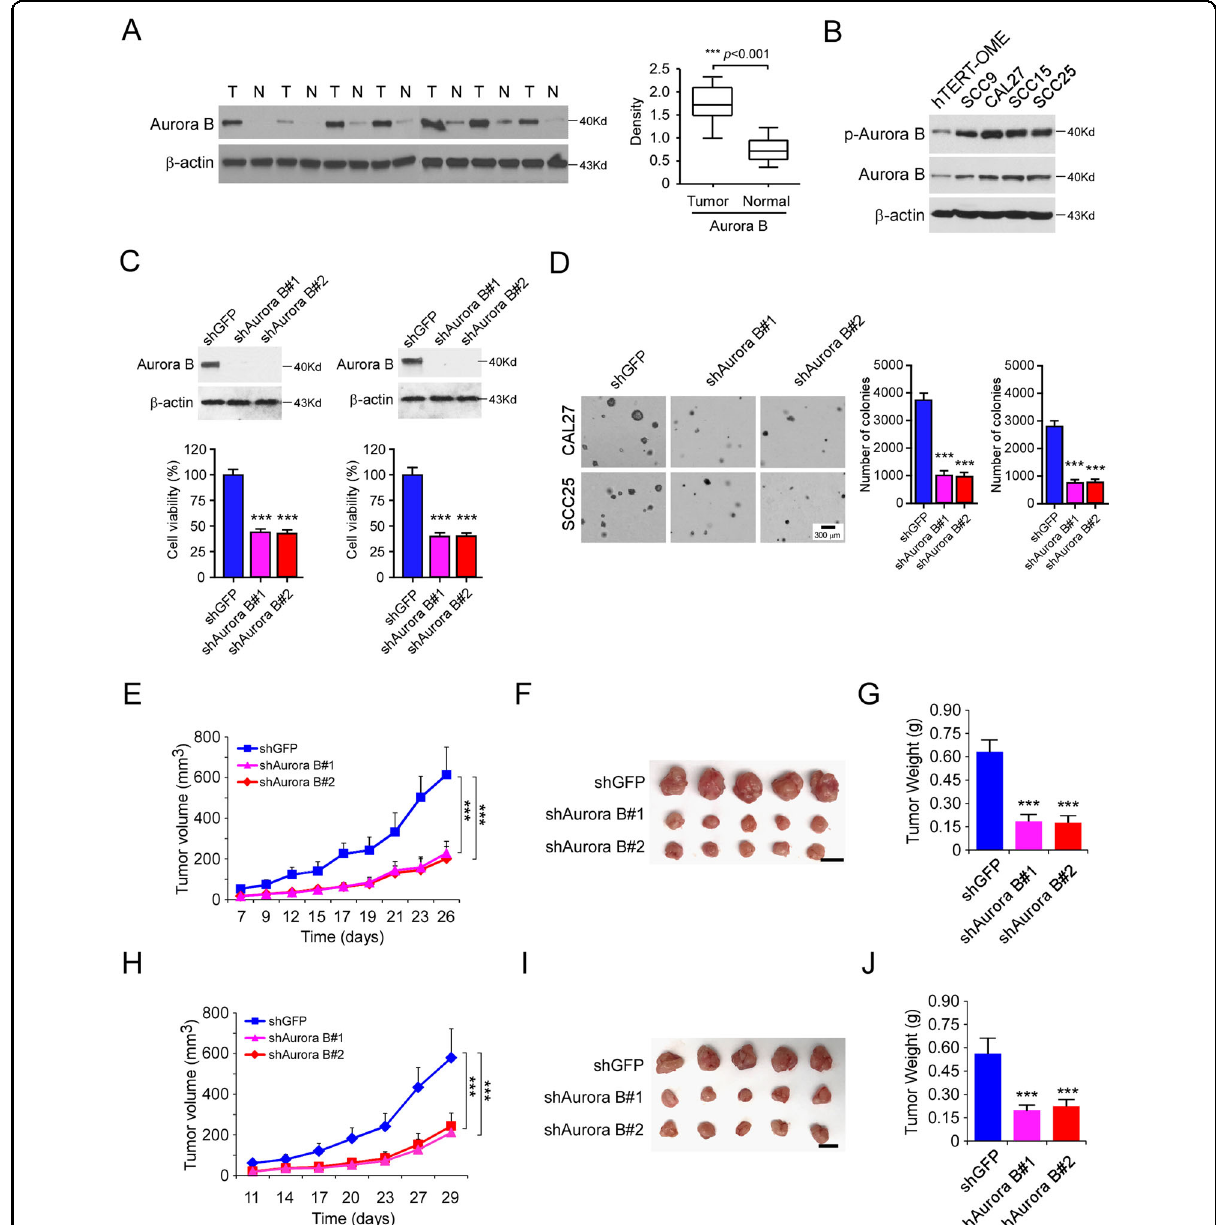
Fig. 1 Aurora B is overexpressed in OSCC tumor tissue. A The representative immunoblotting (IB) results of Aurora B expression in 20 cases of matched OSCC patient tissues and adjacent non-tumor tissues (Mann – Whitney U test). T, tumor; N, adjacent non-tumor tissue. B IB analysis of Aurora B expression in hTERT-OME and OSCC cell lines. C Cell viability of SCC25 (left) and CAL27 (right) cells expressing shGFP or shAurora B. Top, IB analysis of Aurora B expression. Bottom, MTS analysis of cell viability. D Colony formation of CAL27 and SCC25 cells expressing shGFP or shAurora B; n = 3 independent biological replications, one-way ANOVA. Scale bar, 300 μ m. E – G In vivo tumor growth of CAL27 cells expressing of shGFP or shAurora B. The tumor volume ( E ), the image of the tumor mass ( F ), and the weight of the tumor mass ( G ) of CAL27 xenograft tumors; n = 5 mice per group, one-way ANOVA. H – J In vivo tumor growth of SCC25 cells expressing of shGFP or shAurora B. The tumor volume ( H ), the image of the tumor mass ( I ), and the weight of the tumor mass ( J ) of SCC25 xenograft tumors; *** p < 0.001; n = 5 mice per group, one-way ANOVA. For F and I , scale bar, 1